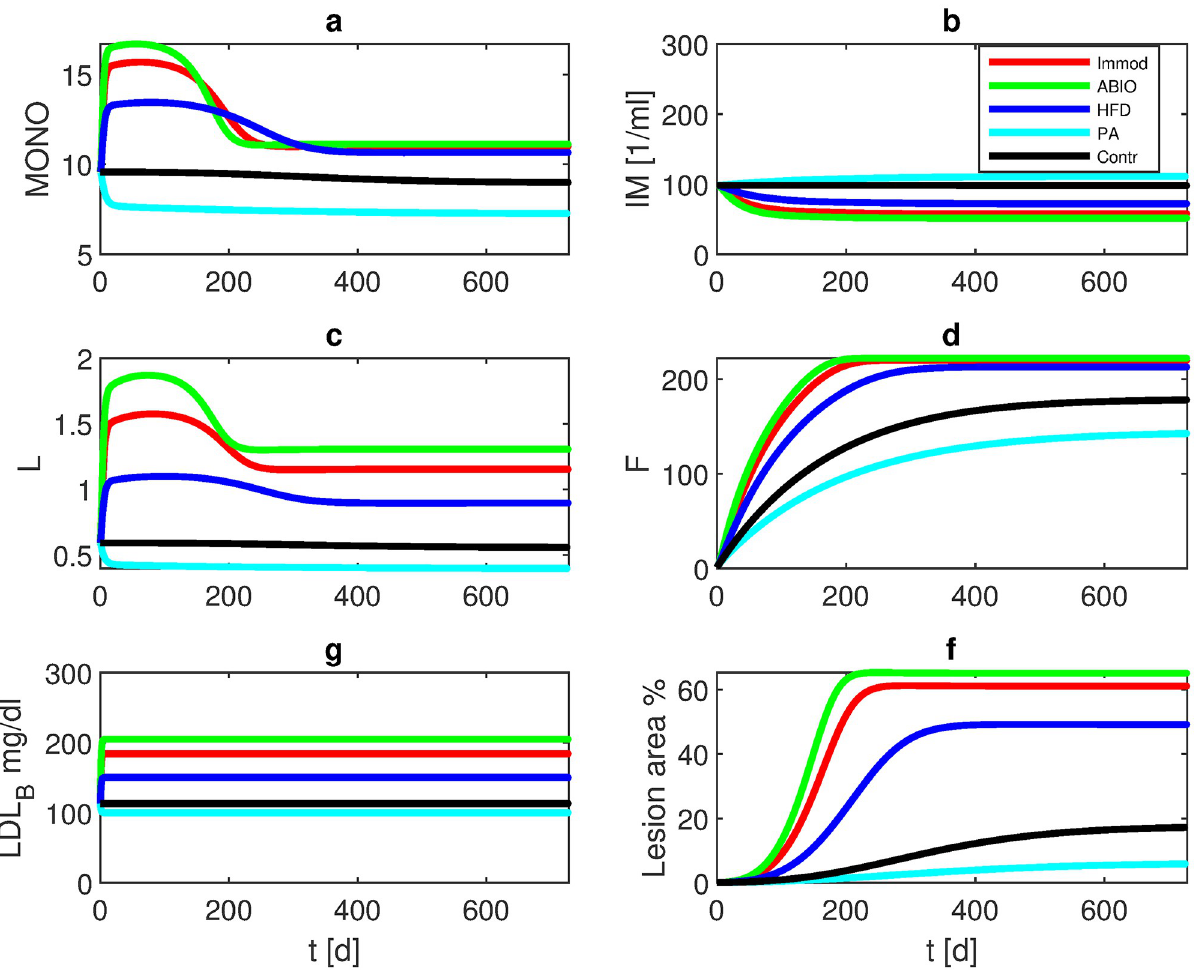
Fig 4. Long term simulation of different single interventions. Simulation is started with R 0 = 0.9996. Over a period of two years, normal diet (Contr), high fat diet (HFD), immune modulating agents (IMMOD), antibiotic drugs (ABIO), or lipid lowering agent (PA) are simulated. The curves represent model results of a) monocytes in plaque, b) macrophages in plaque, c) LDL-C in plaque, d) foam cells, e) LDL-C in blood, and f) lesion area. Different steady-states are established. Respective values are provided in S3 Table in S1 File.